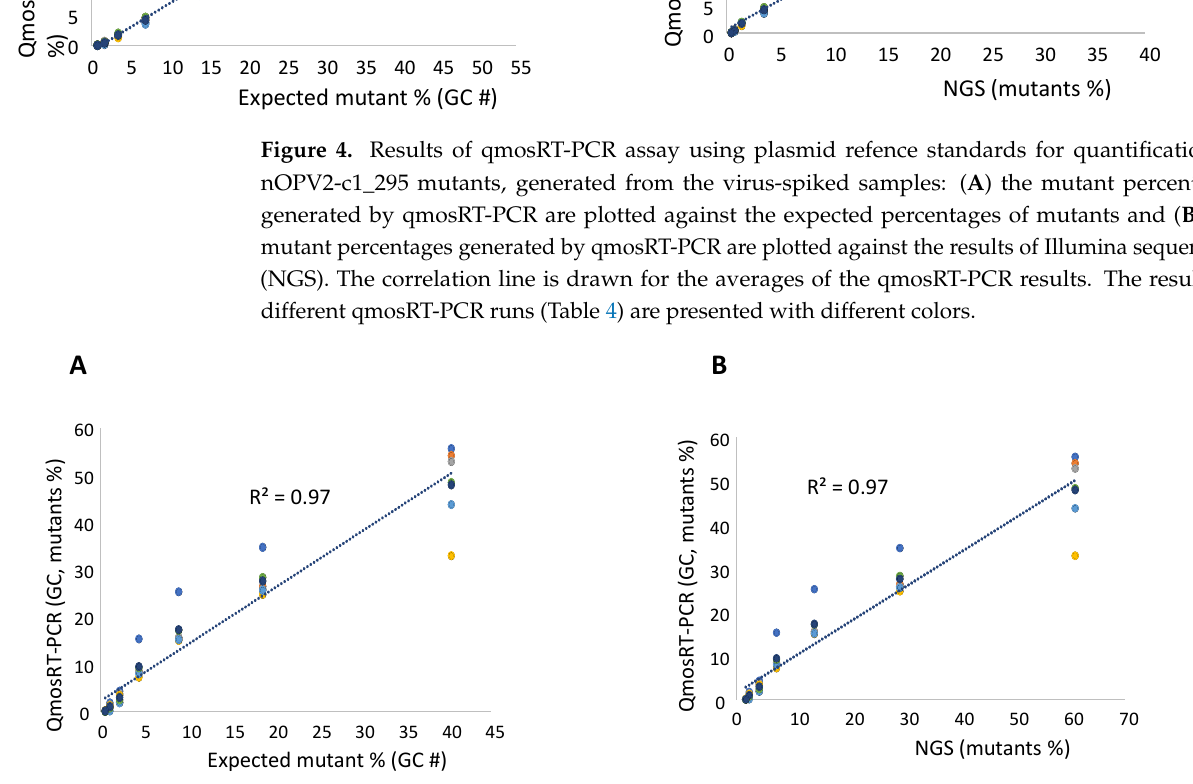
Figure 5. Results of qmosRT-PCR assay using plasmid reference standards for quantification of nOPV2-c1_143 mutants, generated from the virus-spiked samples: ( A ) the mutant percentages generated by qmosRT-PCR are plotted against the expected percentages of mutants and ( B ) the mutant percentages generated by qmosRT-PCR are plotted against the results of the Illumina sequencing (NGS). The correlation line is drawn for the averages of the qmosRT-PCR results. The results of different qmosRT-PCR runs (Table 5) are presented with different colors.